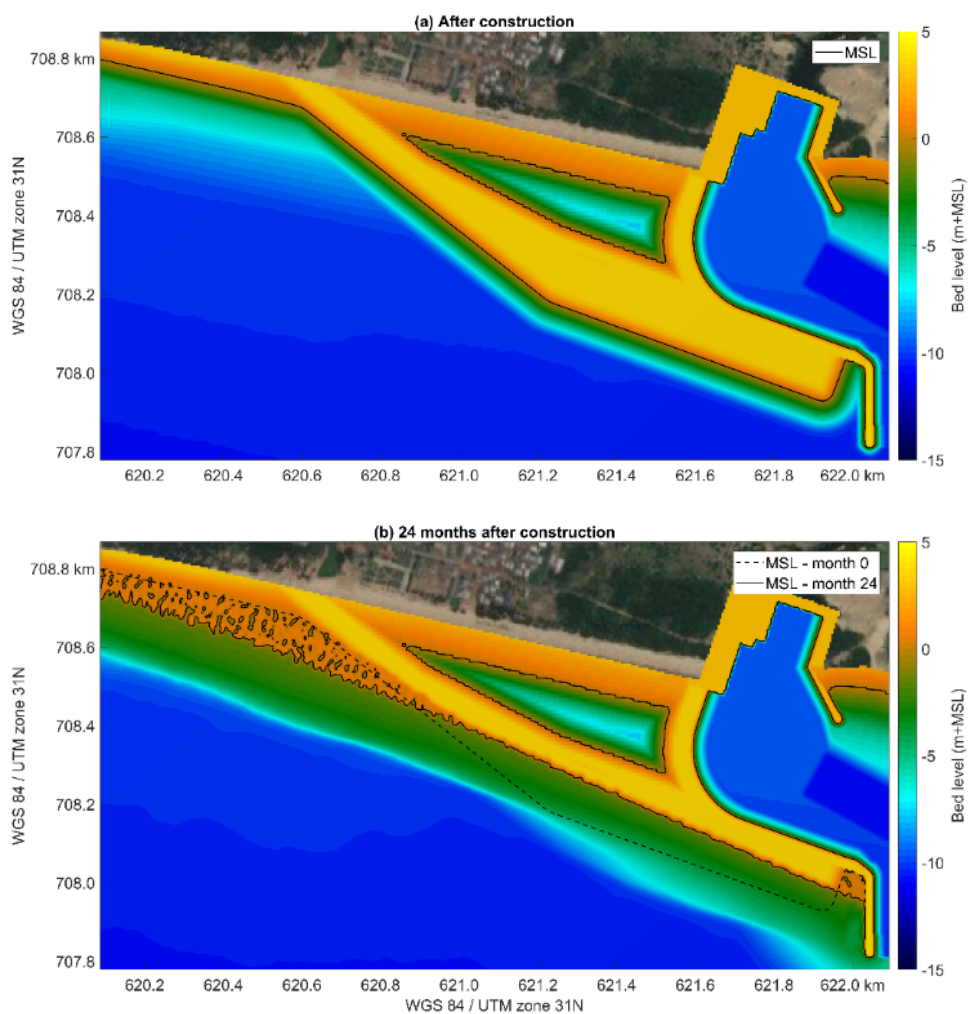
Figure 9. F INEL -S WAN results. ( a ) Bed level during the final construction stage of the Sandbar Breakwater. ( b ) Bed level after 2 years of morphological simulation for the final design.